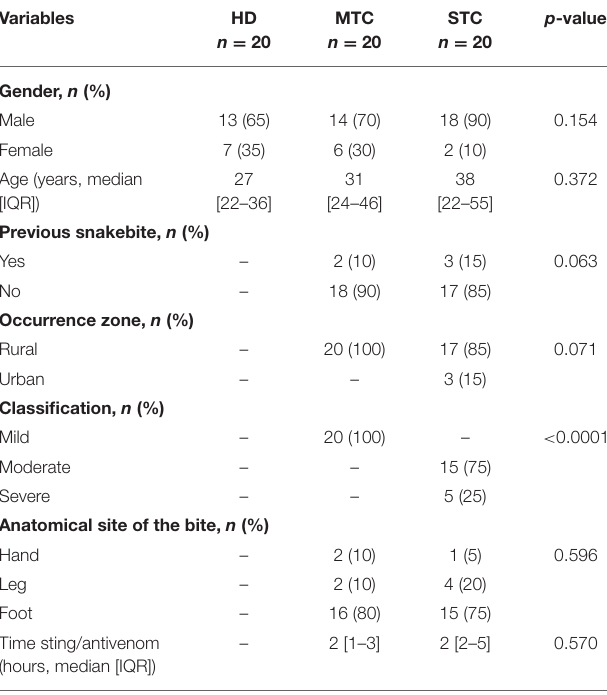
TABLE 1 | Description of the socio-demographic data of HD, MTC, and STC groups.